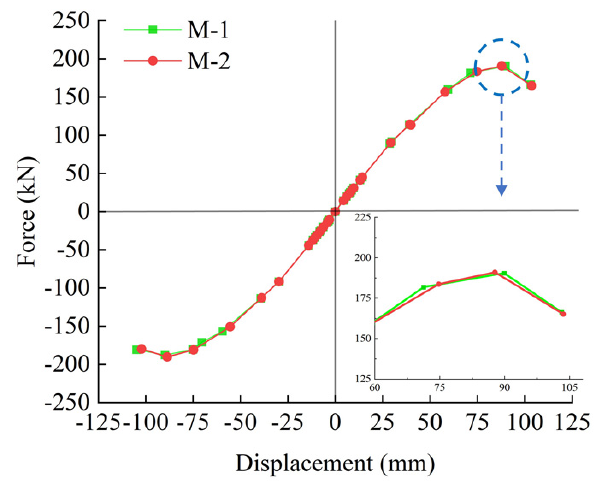
Figure 22. Skeleton curves of M-1 and M-2.